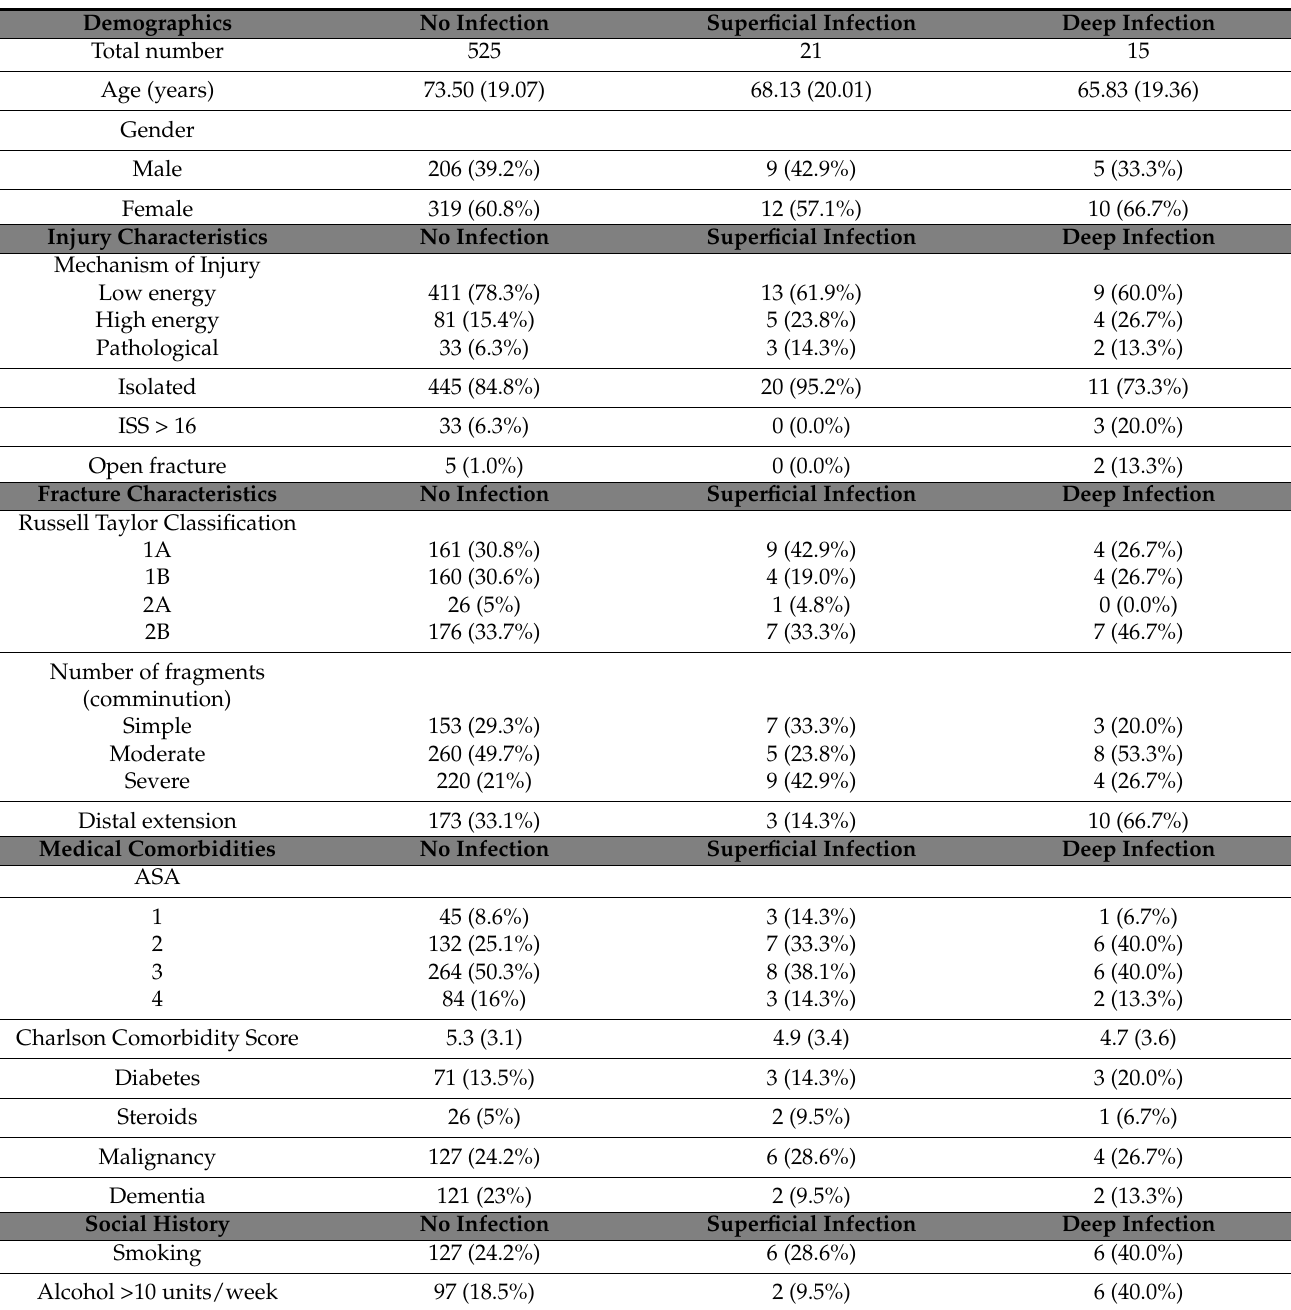
Table 1. Patient demographics and characteristics categorised according to patients with no infection, superficial infection and deep